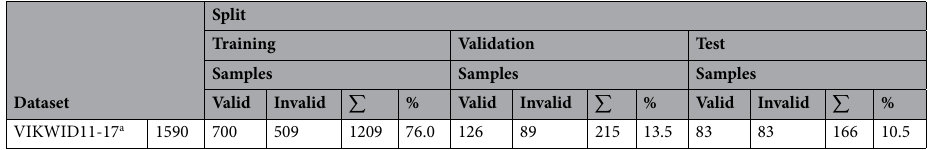
Table 2. Valid/Invalid Killer Whale Identification Dataset 2011–2017 (VIKWID11-17), a human-annotated dataset consisting of valid and invalid identification images (dorsal fin + saddle-patch), utilized to train, validate, and test VVI-DETECT, after applying the interval rule of 5 s with respect to the validation and test set. a VIKWID11-17 Valid/Invalid Killer Whale Identification Dataset 2011–2017.